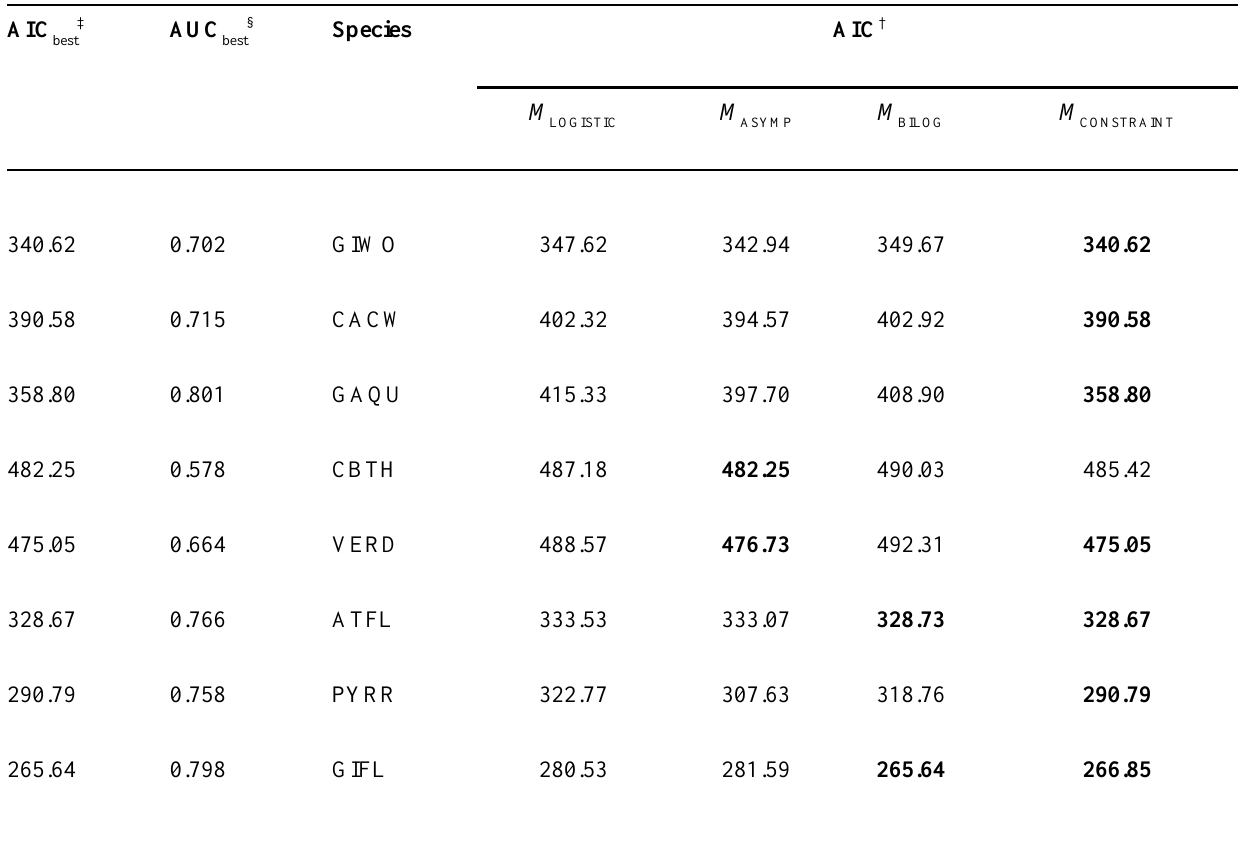
Table 2. Maximum likelihood parameter estimates and model selection criteria for eight Tucson-area desertscrub species. See Table 1 for species names. † Akaike Information Criterion. Boldface indicates £ models considered to have “substantial empirical support,” i.e., AIC–AIC best among models, indicating highest likelihood given the data after penalization for number of parameters. § Mean area under the receiver operating curve (AUC) based on 10-fold cross-validation of the best model. M M M and M represent the logistic, asymptote, bivariate logistic, and LOGISTIC, ASYMP, BILOG, CONSTRAINT constraint models,